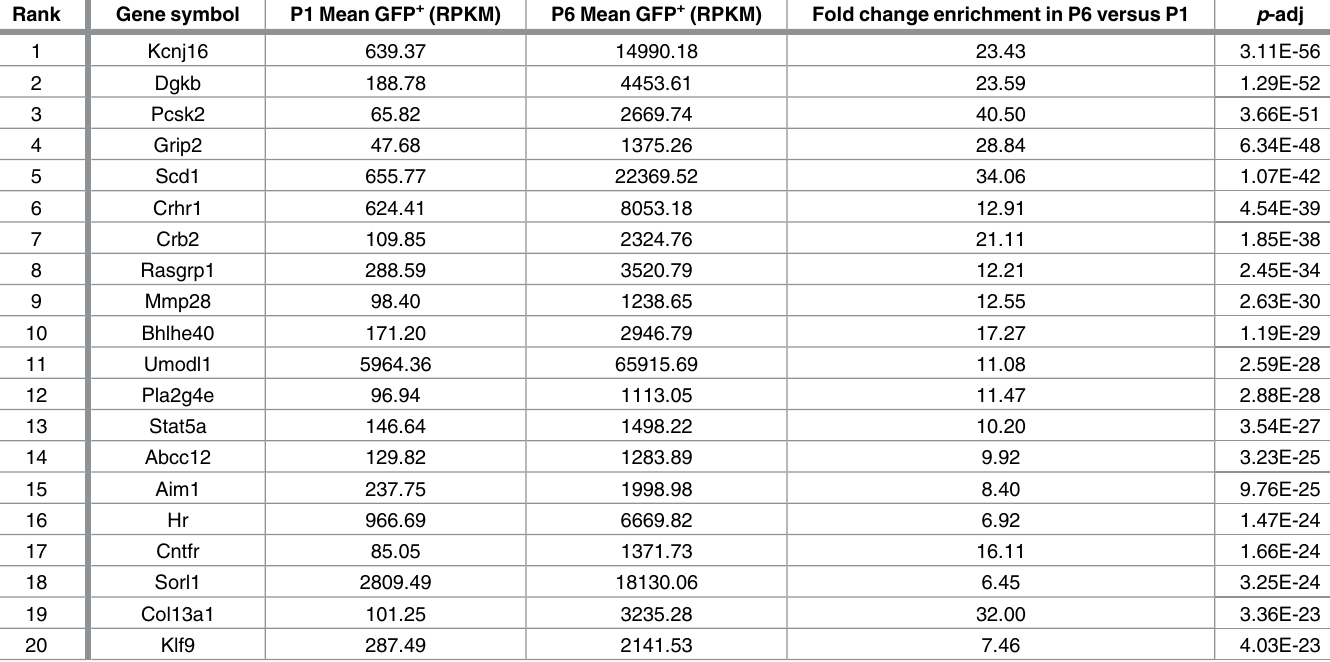
List of the 20 genes showing the greatest fold-change enrichment in P6 Lfng-GFP + cells compared P1 Lfng-GFP + cells. Ranking is based on the p value. The mean expression level (RPKM) is shown, together with the fold change of enrichment in P6 versus P1 cells. p- adj = adjusted p -value for the difference between P6 and P1